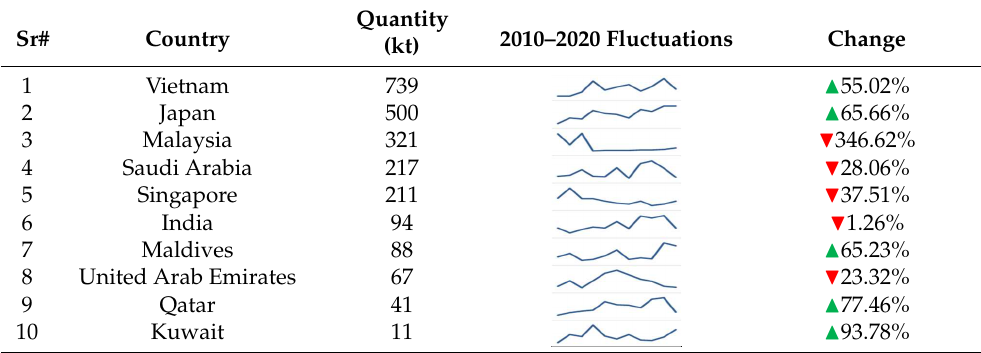
Table 4. Top ten exporters of Sri Lankan crops based on last eleven years (2010–2020), ( ▲ Positive change in imports from trade partners from 2010 to 2020, ▼ Negative change in imports from trade partners from 2010 to 2020).